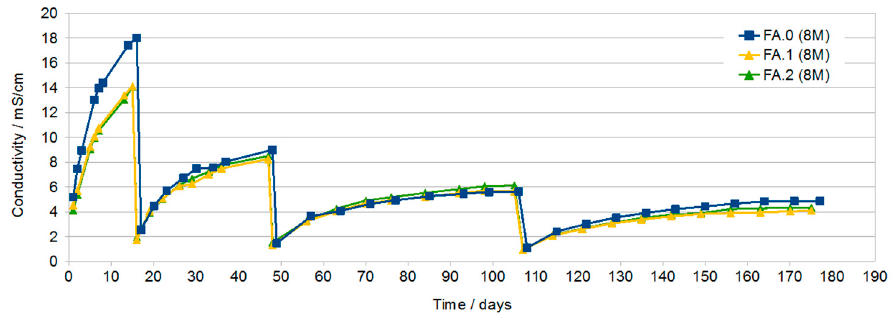
Figure 2. Of samples FA.0 (8 M), FA.1 (2% G40), and FA.2 (4% G40) as a function of immersion time with periodic water changes.